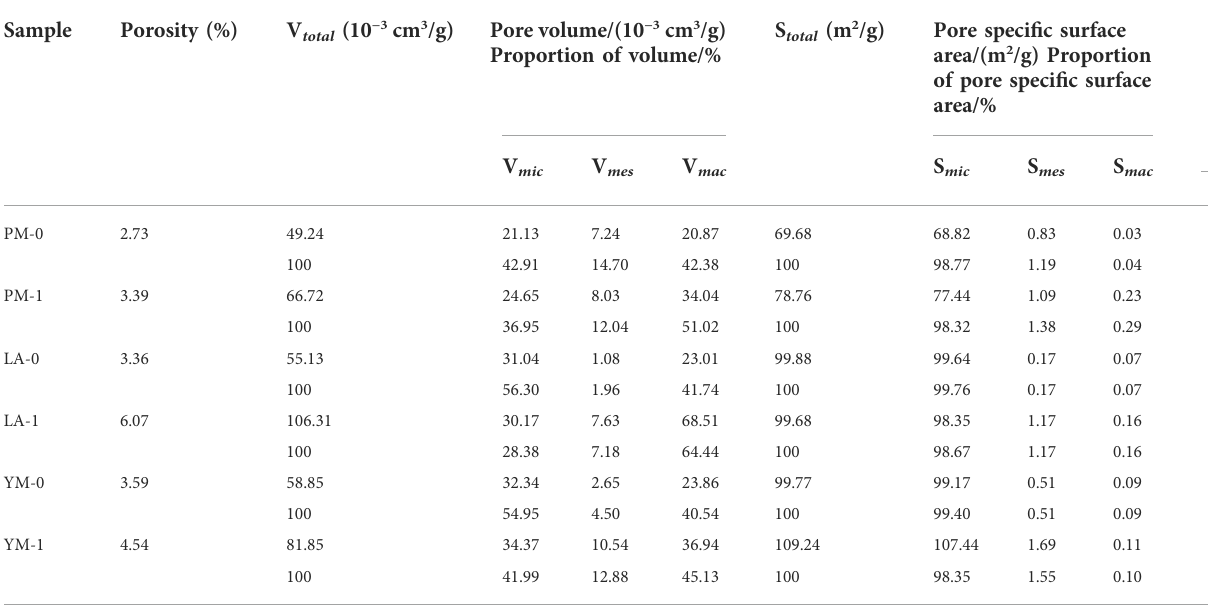
TABLE 4 Full-sized pore structural parameters of the raw and acidi fi ed coal samples.